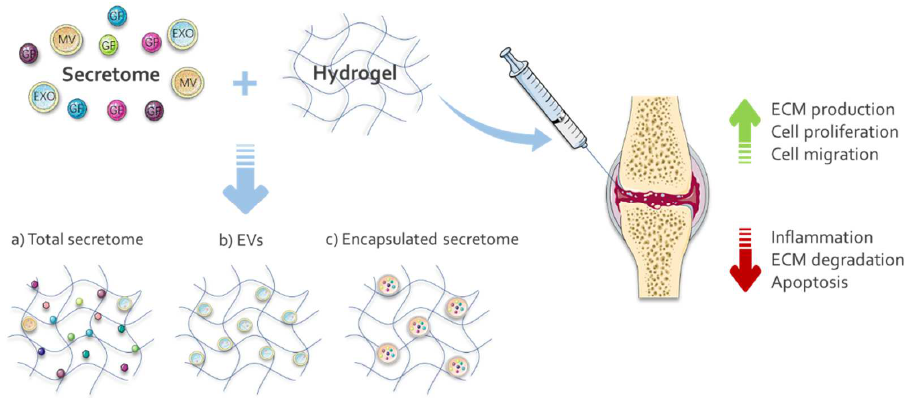
Figure 3. Functionalization strategies of hydrogels with secretome (total or only EVs) for treatment of cartilage damage. Secretomes, composed of soluble factors, as growth factors (GF), and extracellular vesicles (EVs) (microvesicles (MVs) and exosomes (EXO)), can be directly associated with hydrogel (with crosslinkers or not, ( a , b )) or to be initially encapsulated and then incorporated with the hydrogel ( c ). The images were obtained from Servier Medical Art (http://smart.servier.com/, Accessed on 7 April 2022), licensed under a Creative Commons Attribution 3.0 Unported License.